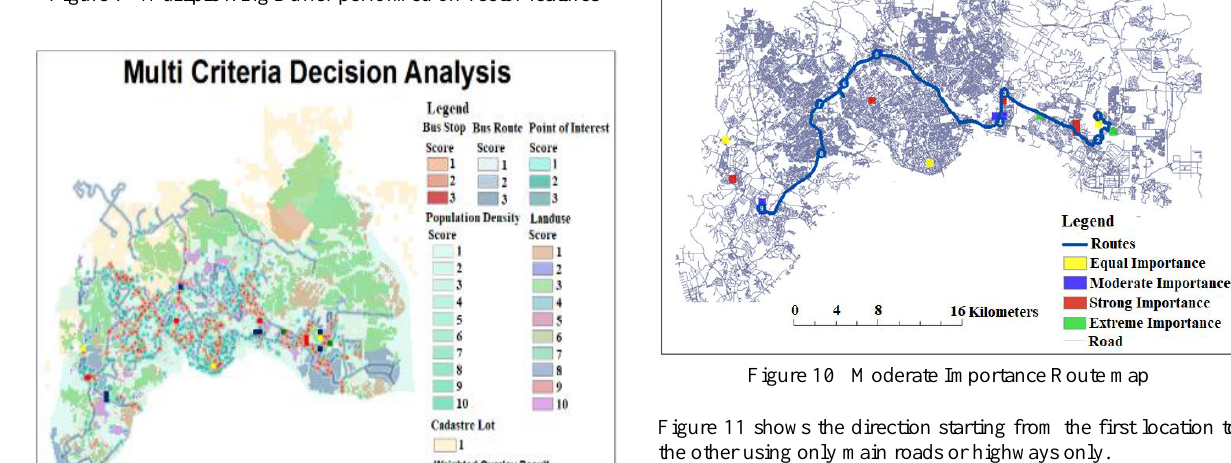
Figure 7 Multiple Ring Buffer performed on vector features